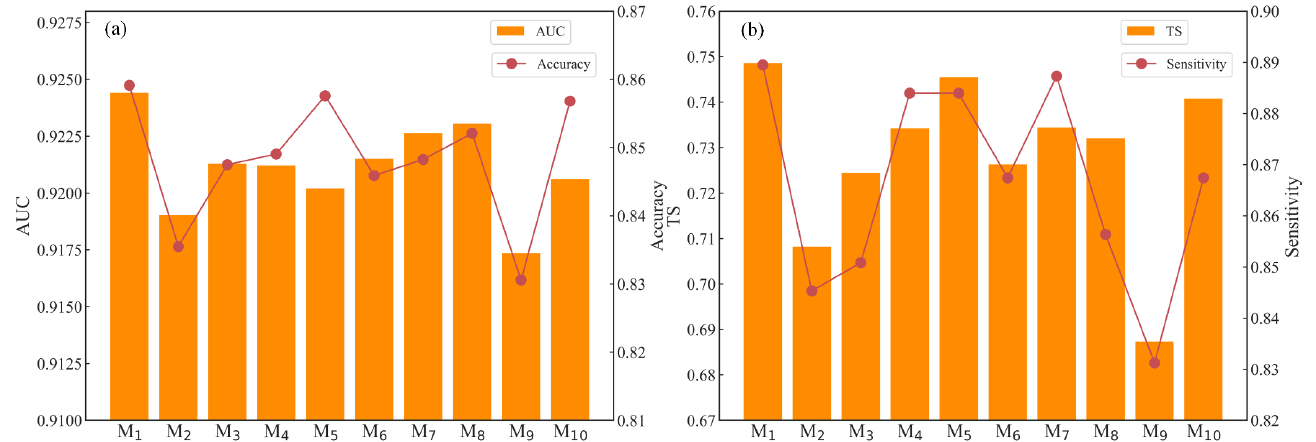
Figure 11. Comparison of cross-validation results of 10 candidate models. ( a ) Validation metrics: AUC and Accuracy, ( b ) Validation metrics: TS and Sensitivity.